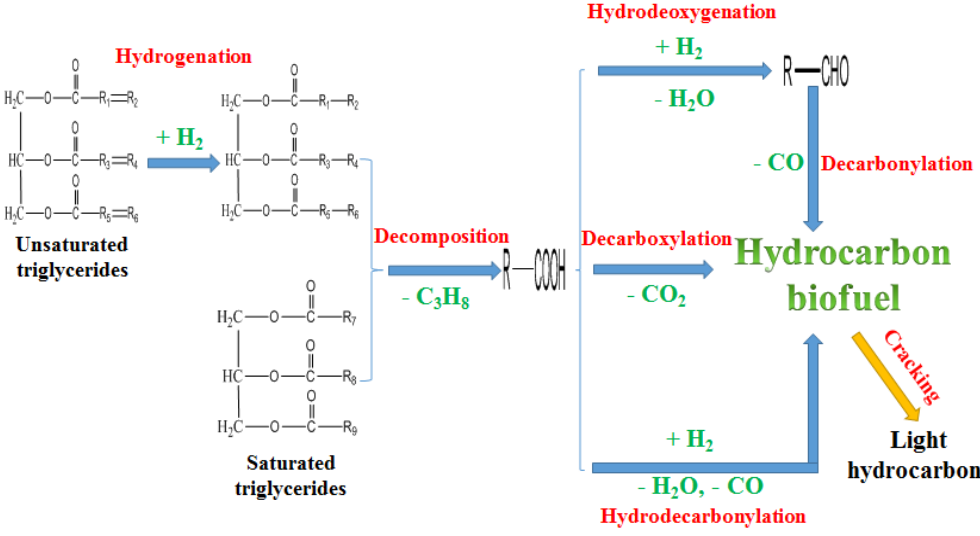
Figure 2. A proposed reaction pathway in the hydroprocessing of vegetable oil to hydrocarbon biofuel.